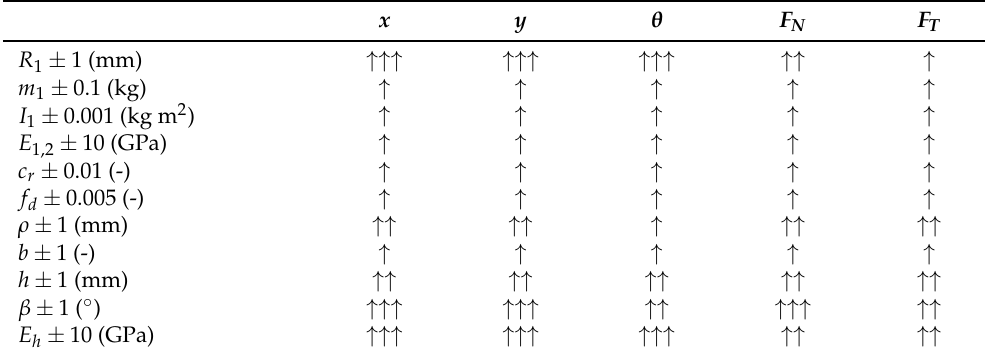
Table 4. Parametric analysis for the event-driven models. One arrow (low influence), two arrows (medium influence), three arrows (high